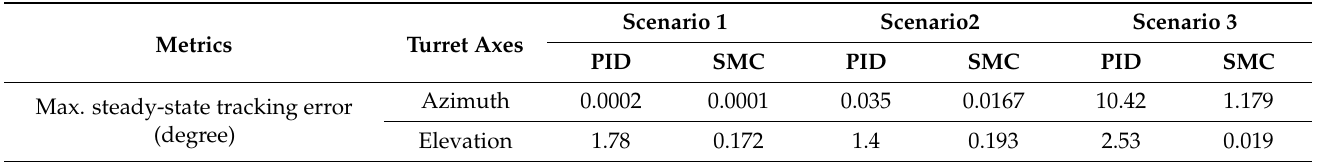
Table 9. Response performance of PID and SMC controller for turret system.